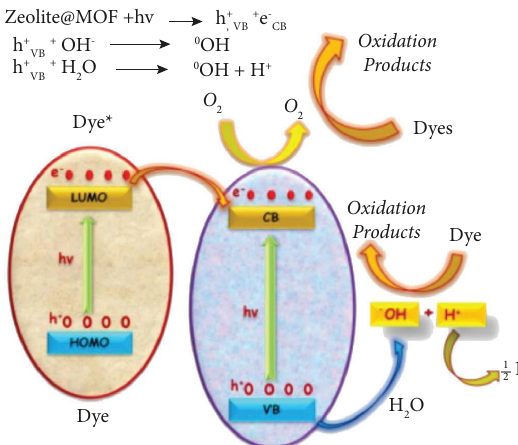
Figure 32: Sensitization-mediated superoxide radicals ( • O